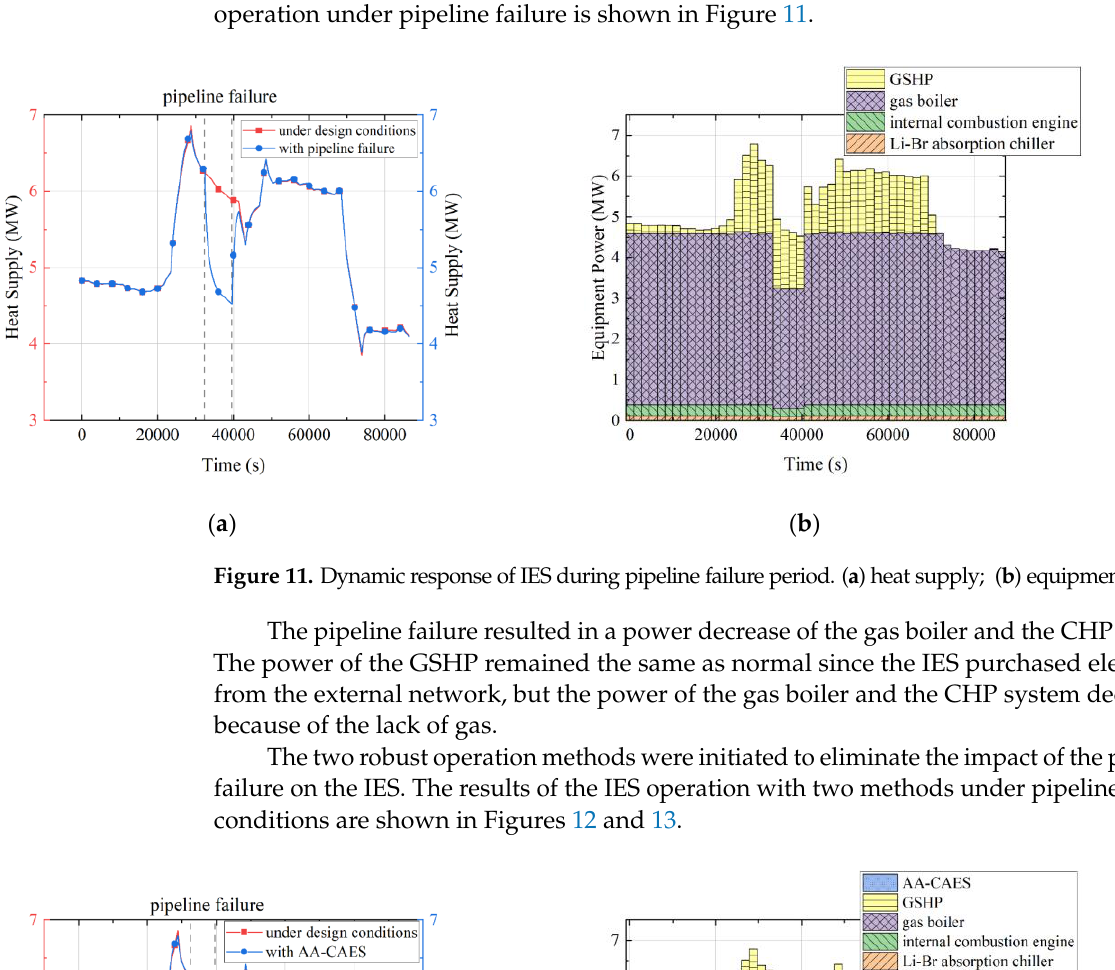
Figure 11. Dynamic response of IES during pipeline failure period. ( a ) heat supply; ( b ) equipment power.